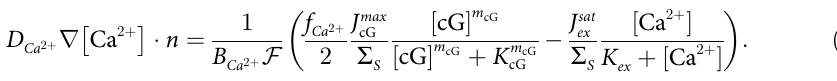
PLOS ONE | https://doi.org/10.1371/journal.pone.0258721 October 28,